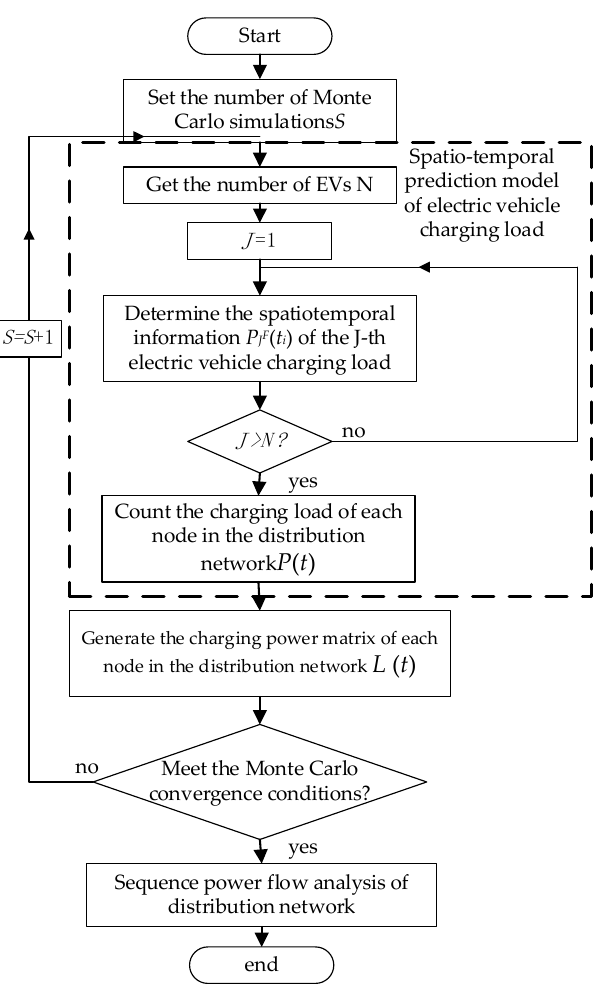
Figure 6. Monte Carlo simulation flow chart.